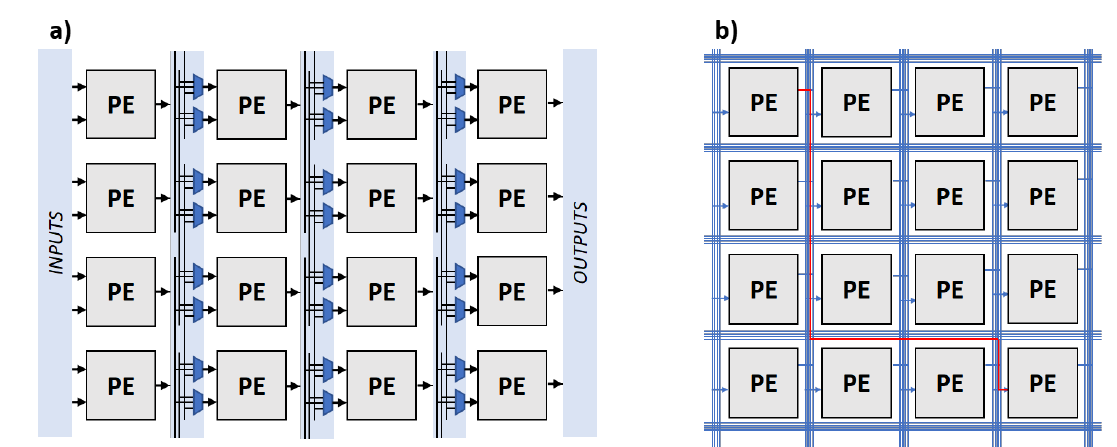
Figure 5. Other patterns used in Virtual CGRAs: linear dataflow ( a ) and configurable each-to-any (e.g., crossbar) connection ( b